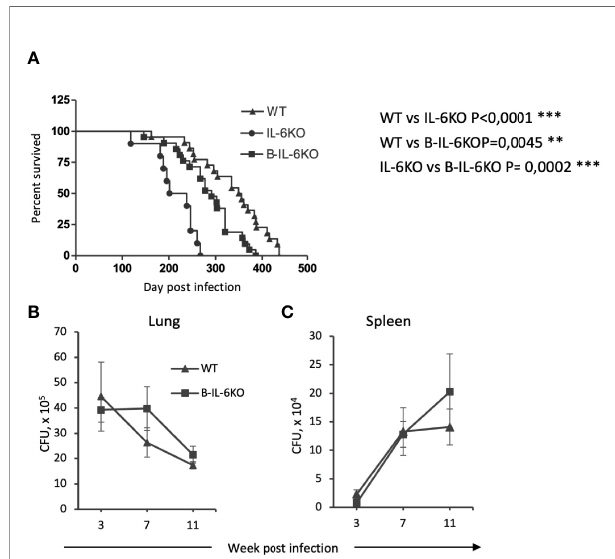
FIGURE 1 | Mice lacking il6 expression in all cells (IL-6KO), or in B-cells (B- IL-6KO), have a shorter life span after TB infection compared to control animals. (A) Survival time of mice of the three strains after aerosol infection with M. tuberculosis H37Rv, ~100 CFU per mouse. Data from two identical experiments were summarized, N = 10-25 mice for groups, log-rank test. (B, C) Mycobacterial counts in lungs and spleens of infected WT and B-IL- 6KO mice at 3, 7 and 11 weeks post infection. Data from one of two similar experiments are displayed as the mean ± SD, 4-5 mice per group per time- point. No signi fi cant differences between the